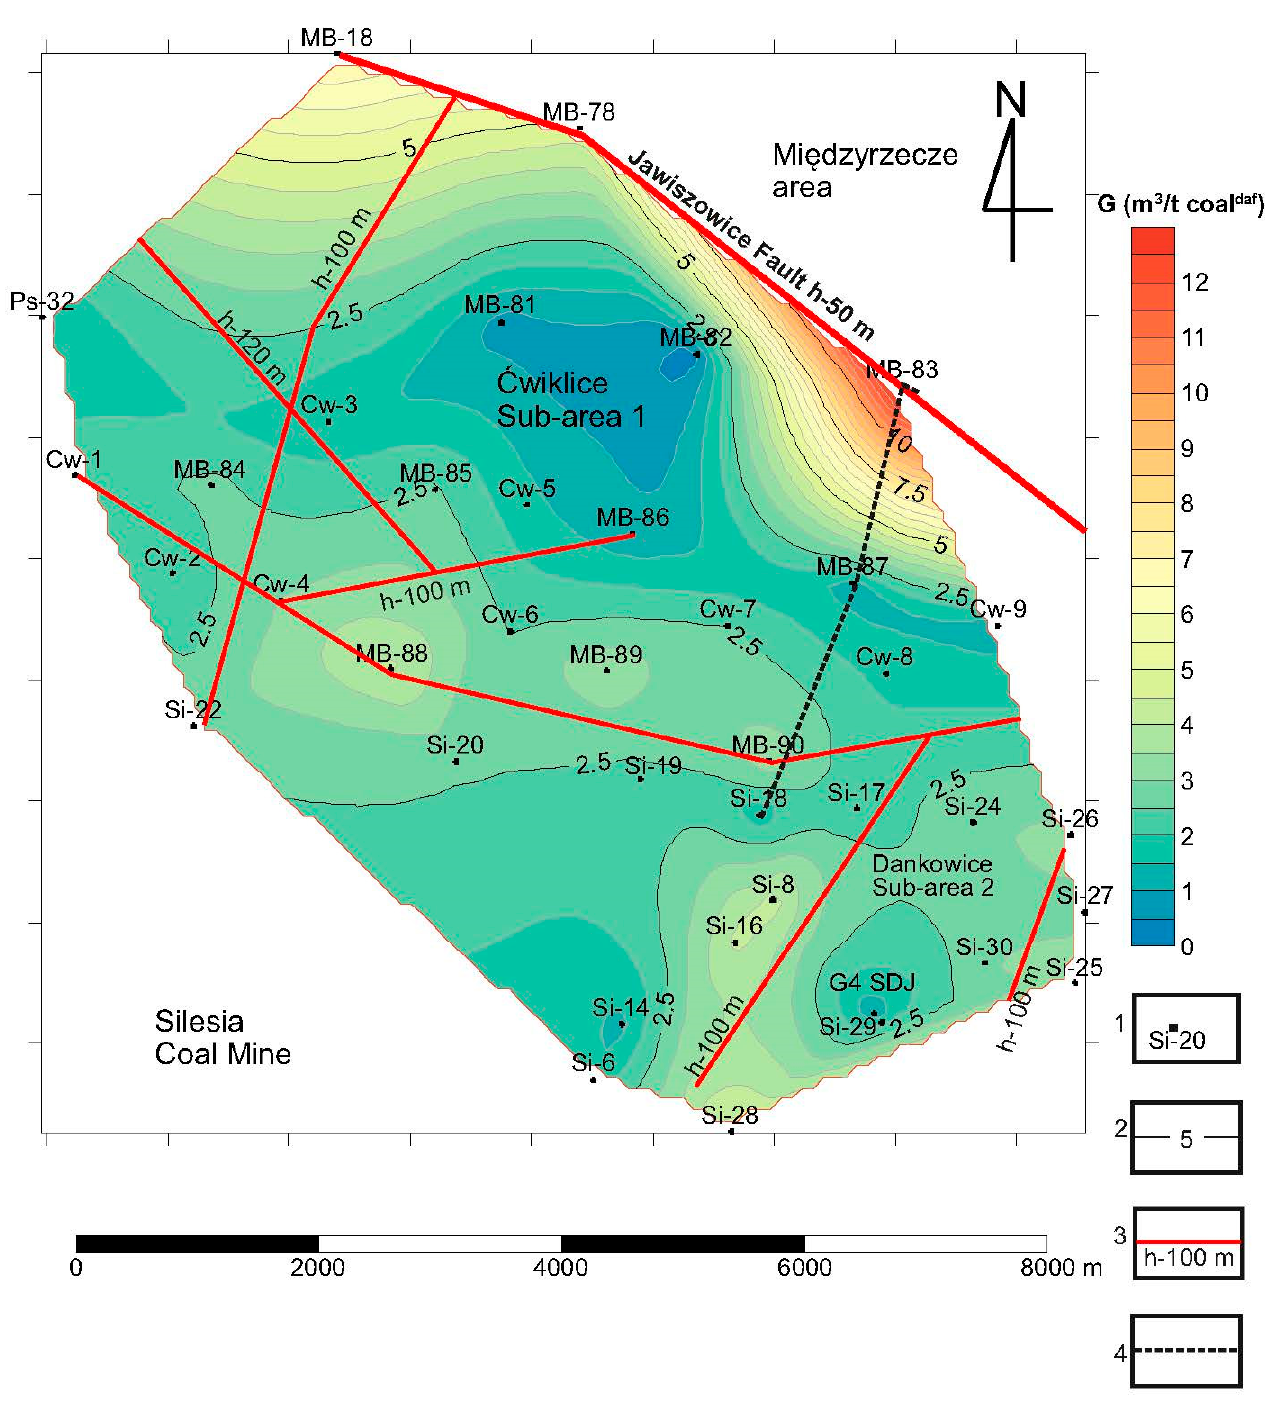
Figure 7. Methane content (G) distribution at the 800 m level below ground; 1—borehole, 2—line of methane content (m 3 /t coal daf ), 3—important faults, 4—trace of cross-section in Figure 11.